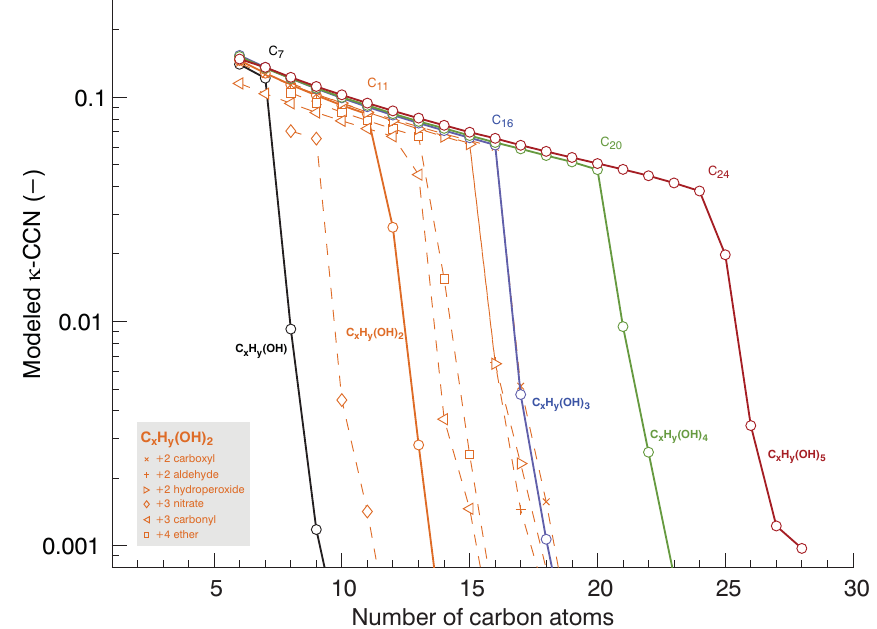
Figure 3. Modeled κ values for homologous series of functionalized n -alkanes. Solid lines correspond to alkanes with 1–5 non-terminal hydroxyl groups. Orange dashed lines correspond to further functionalized dihydroxy alkanes as described in the legend. Colored carbon numbers (C 7 , C 12 , C 16 , C 20 , and C 24 ) correspond to the largest carbon number without miscibility-limited activation for the respective hydroxy alkanes